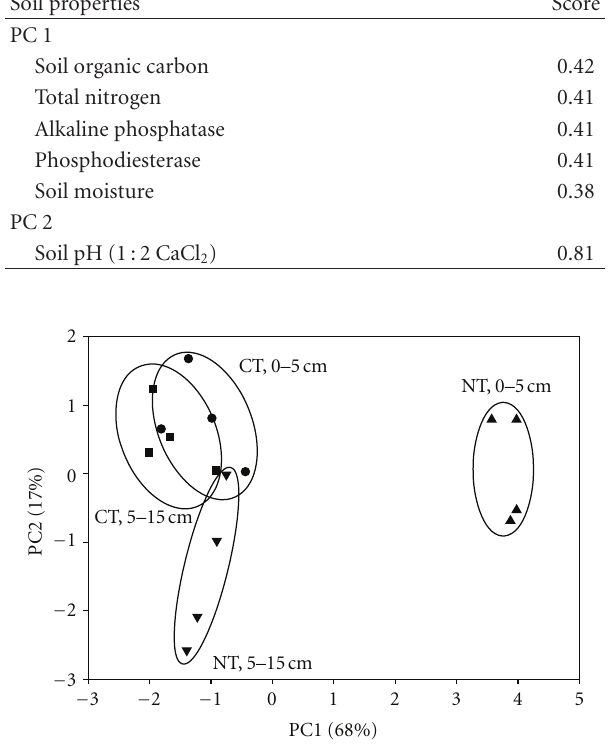
Table 6: Soil physicochemical and enzyme variables having scores ≥| ± 0 . 38 | for the first two principal components. Soil properties